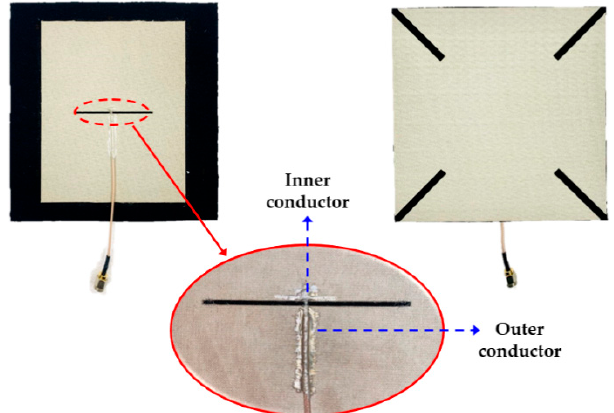
Figure 5. Top and bottom view of the fabricated antenna (inset is a zoomed-in photo of the feeding area).